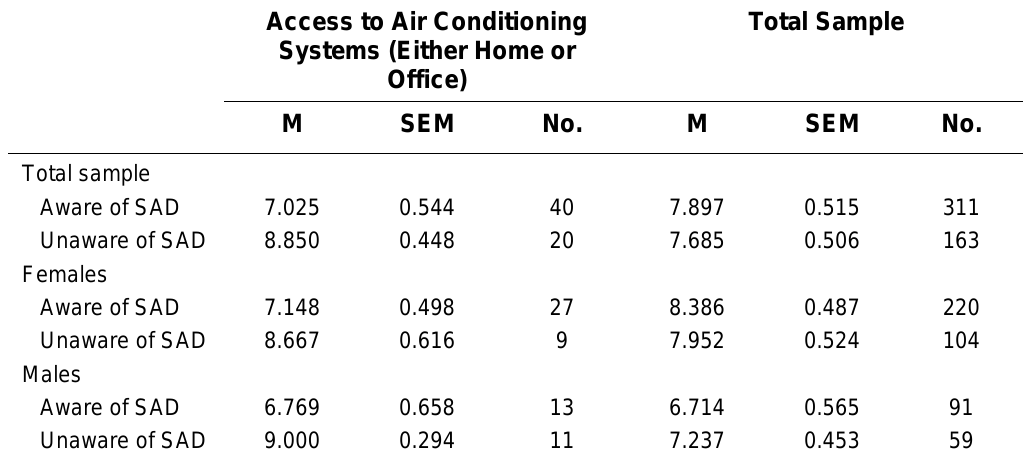
GSS by awareness of SAD, Access to Air Conditioning Systems, and Gender Access to Air Conditioning Systems (Either Home or